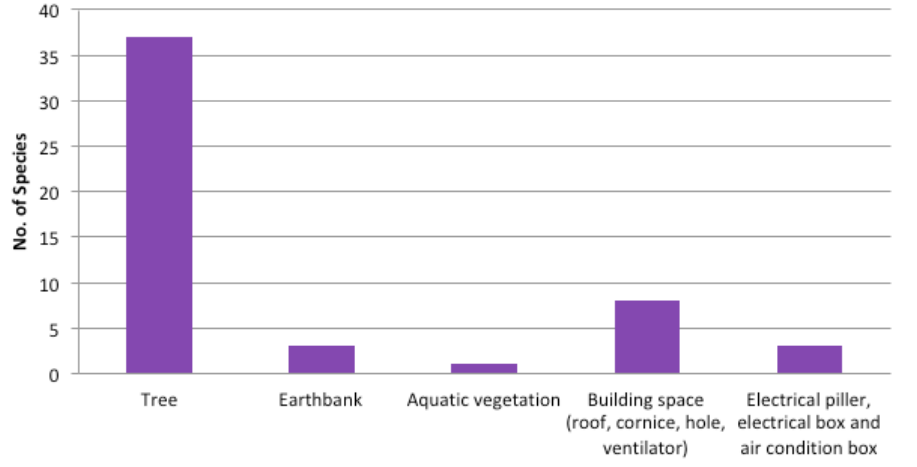
Figure 2. Percentage of species recorded nesting by type of nest site preferred in Jahangirnagar University